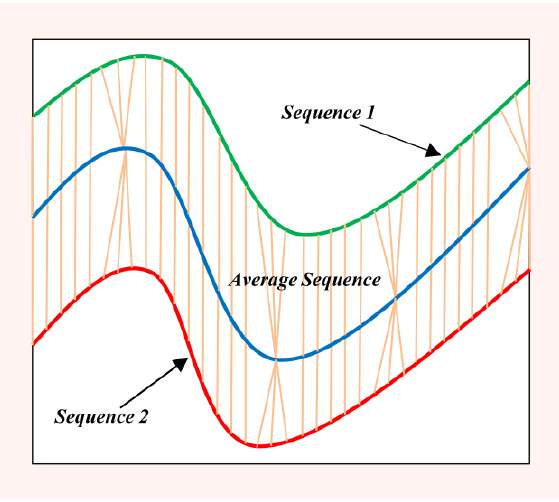
Figure 2. Illustration of the DBA method to acquire the average sequence for two sequences (1 and 2). Algorithm 1. DTW barycenter average